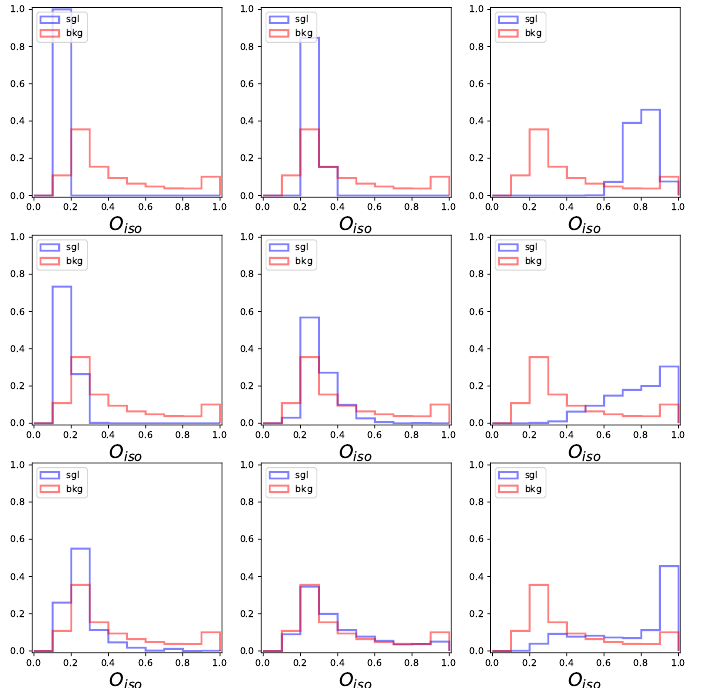
Figure 19 . Novelty score according to O iso for the 2D Gaussian testing samples corresponding to the same BPs as in figure 3.